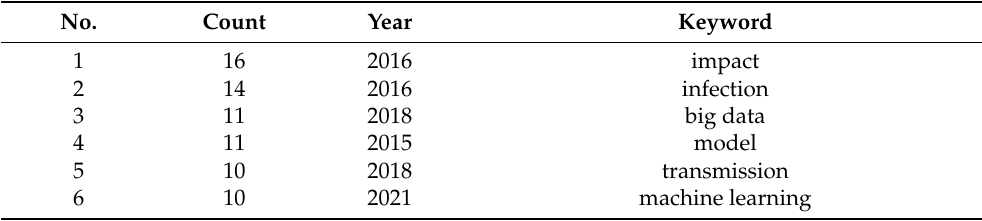
Figure 10. CS map of keyword analysis of studies of epidemic control based on big data research. Table 9. Top 15 most productive keywords in studies of epidemic control based on big data research, extracted through CS analysis.